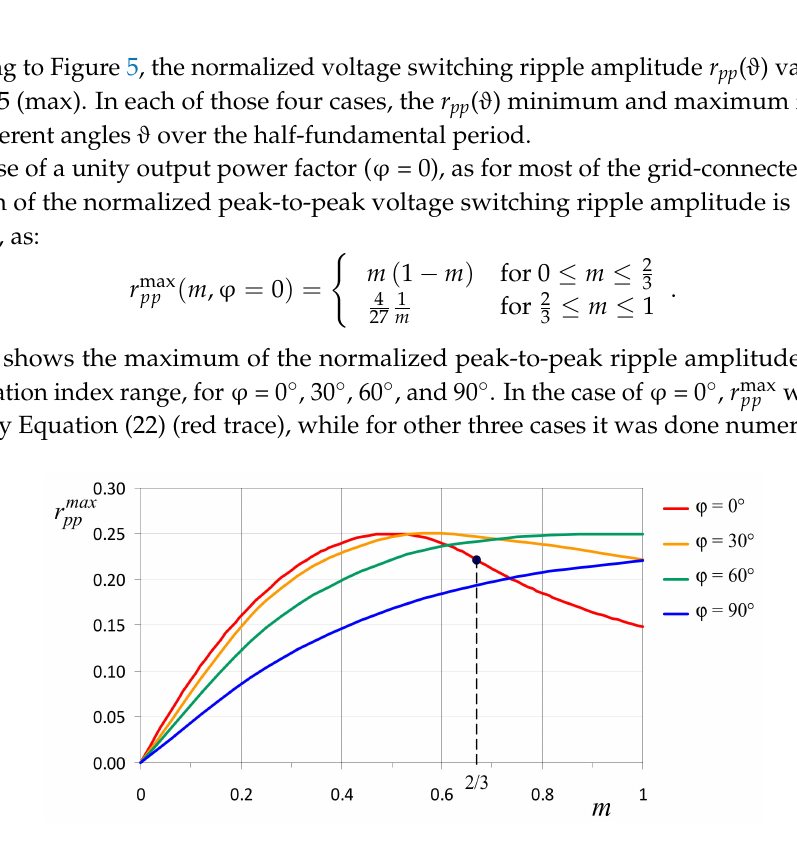
Figure 6. Maximum of normalized peak-to-peak voltage switching ripple amplitude vs. modulation index for different output phase angles ϕ = 0 ◦ , 30 ◦ , 60 ◦ , and 90 ◦